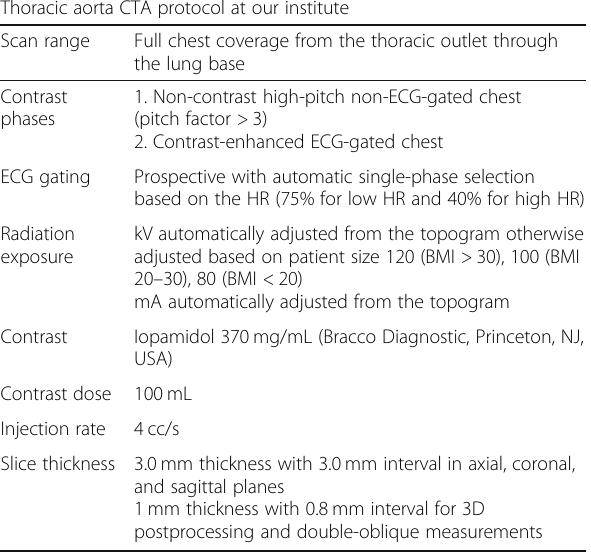
Table 1 Dedicated CT angiography protocol for thoracic aortic